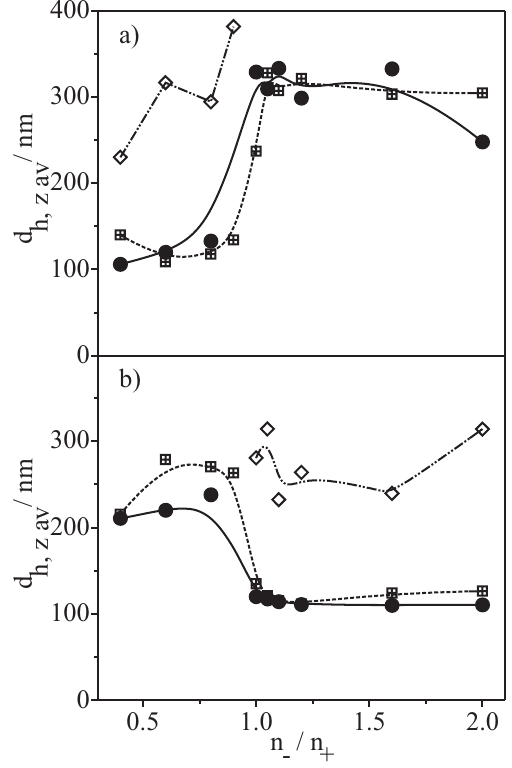
Figure 3. The z average hydrodynamic particle size d stable PECs prepared on procedure a and b. ( a ) PC is starting solution; ( b ) PA is starting solution; ● Eth/Eth; ⊞ Isob/Isob and ⃟